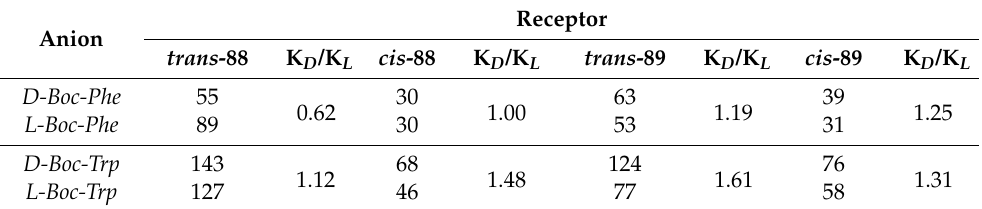
Table 6. Chiral recognition of tetrabutylammonium salts of N -Boc-protected phenylalanine (Phe) and tryptophan (Trp) by trans - and cis -isomers of receptors 88 and 89 in DMSO- d 6 + 0.5% H 2 O by titration under 1 H NMR